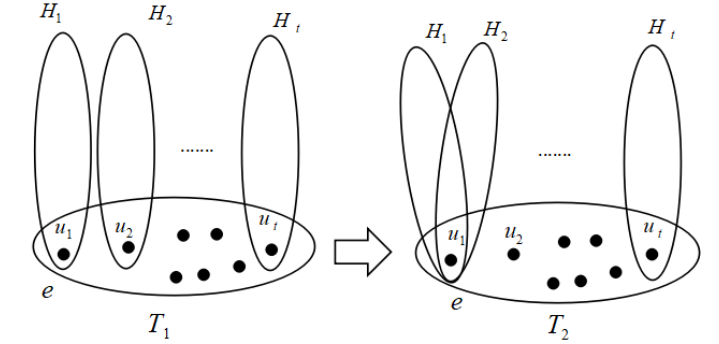
Figure 1. Transformation